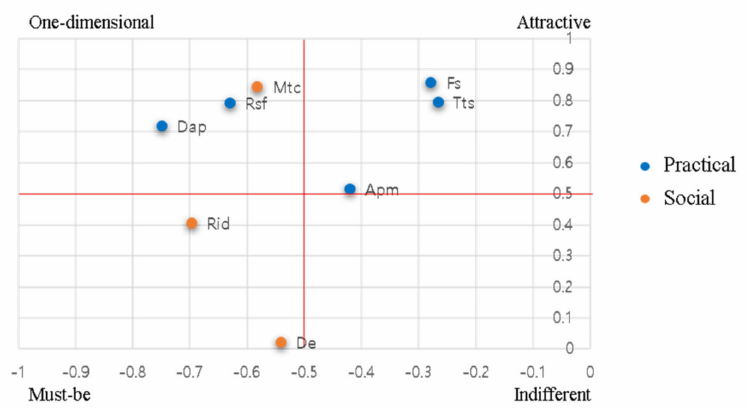
Figure 5. Factor positions for reliable